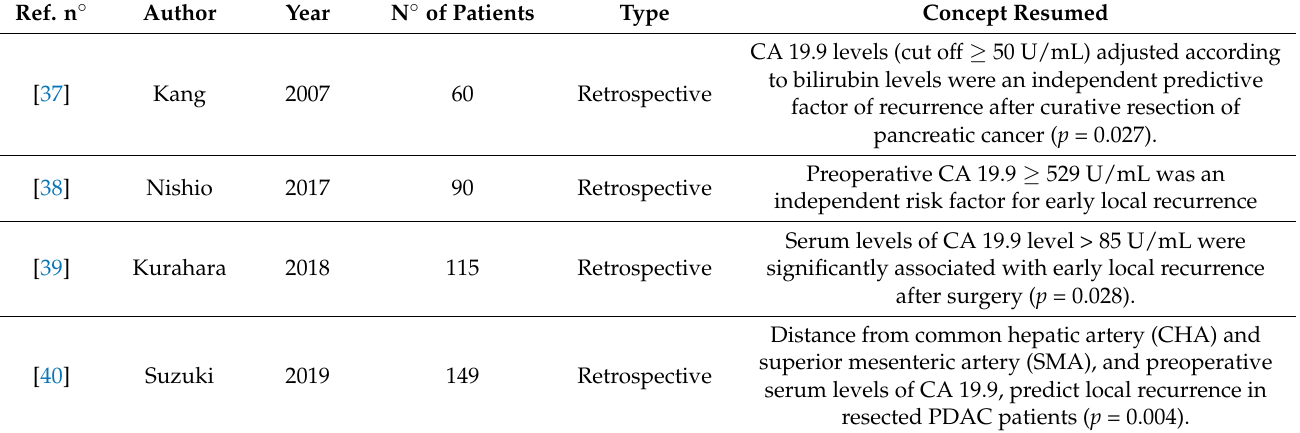
Table 4. Main characteristics and findings of studies reporting data about association between CA 19.9 levels and early local